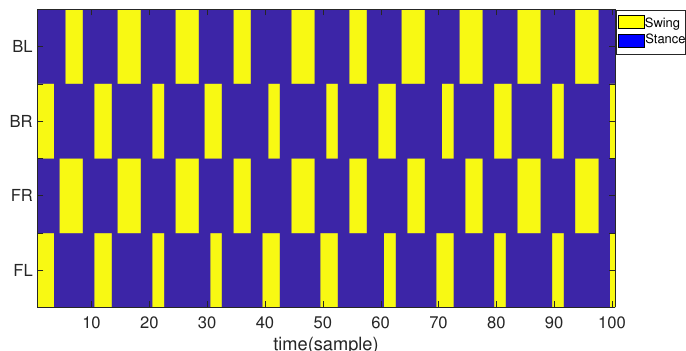
Figure 4. Stepping diagram obtained during the trot gait with m 0 = m 2 = − 1.